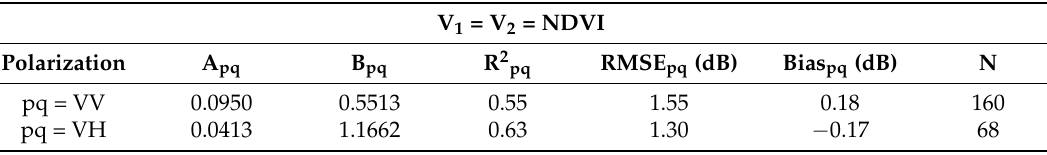
Table 2. Fit of Water Cloud Model (WCM) parameters for each polarization (pq = VV and VH) using training dataset. N is the number of points used in the